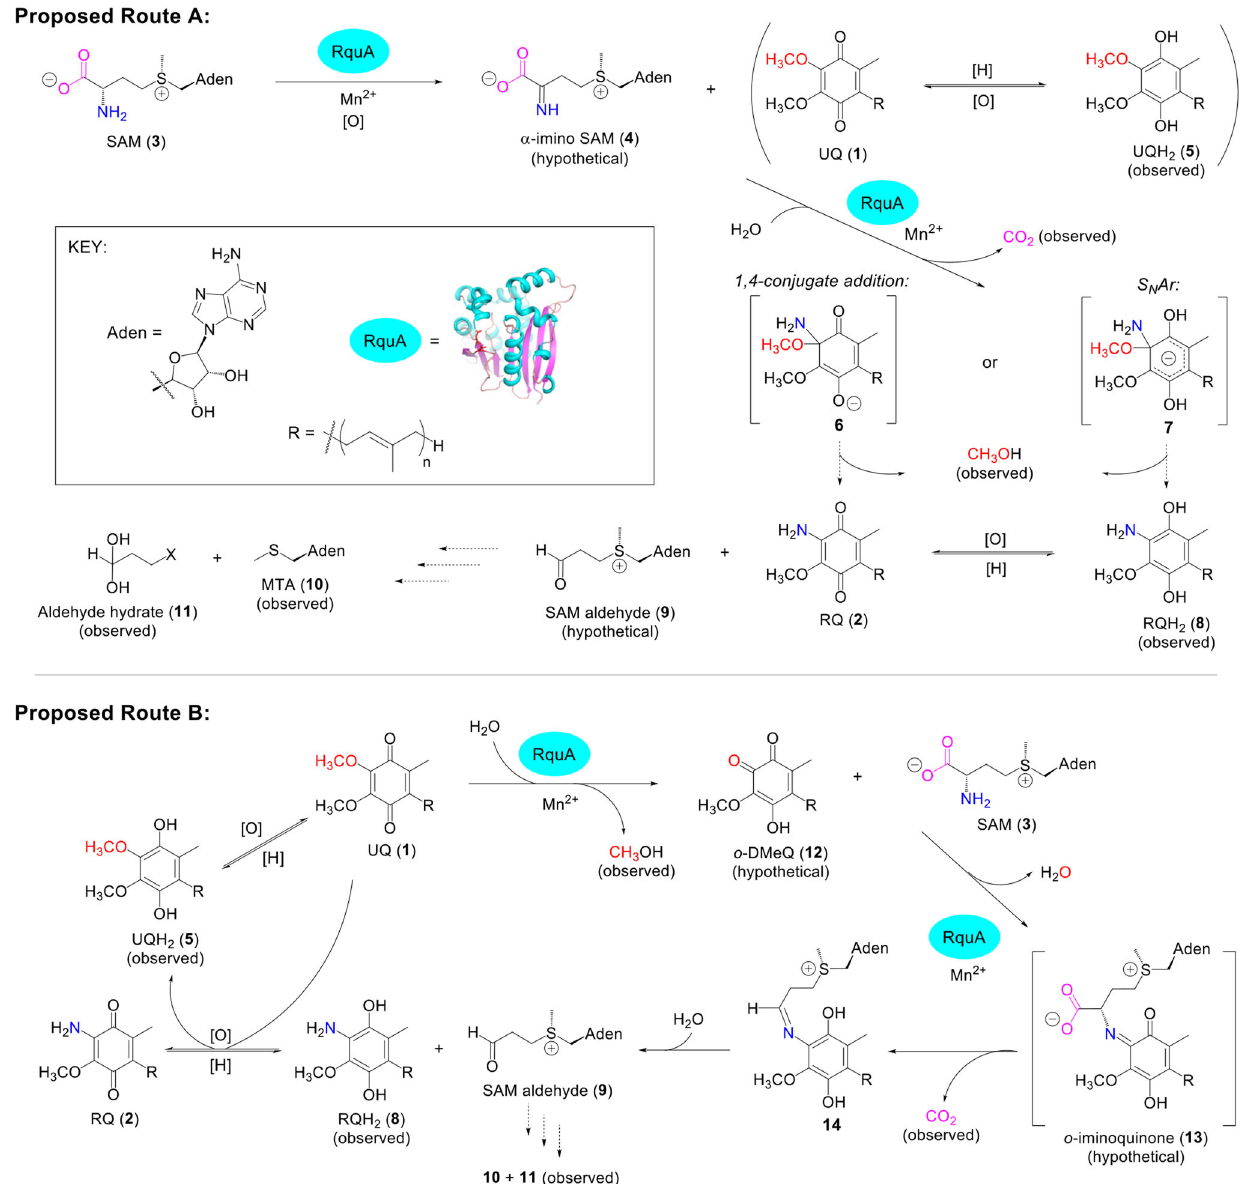
Fig. 6 Proposed routes for the RquA reaction. Ubiquinone (UQ, 1 ) and S -adenosyl- L -methionine (SAM, 3 ) are required substrates of RquA for the biosynthesis of rhodoquinone (RQ, 2 ). The α -amino group (blue) from SAM is transferred to form RQ and decarboxylation (magenta) is observed. The reaction requires the presence of Mn 2 + and both ubiquinol (UQH 2 , 5 ) and rhodoquinol (RQH 2 , 8 ) intermediates are detected during the in vitro assay, as well as CH 3 OH (red), methylthioadenosine (MTA, 10 ), and an aldehyde hydrate ( 11 ). Proposed Route A involves oxidation to form α – imino SAM ( 4 ), followed by decarboxylation and amino substitution via either a 1,4-conjugation addition (intermediate 6 ) or a nucleophilic aromatic substitution (S N Ar, intermediate 7 ) to produce RQ or RQH 2 , respectively. Proposed Route B fi rst assumes the demethylation of UQ to form ortho -demethylubiquinone ( o - DMeQ, 12 ) before the addition of SAM to form an o -iminoquinone ( 13 ), which generates RQH 2 after decarboxylation and hydrolysis. RQH 2 can be oxidized to RQ in either route. Both routes also propose the formation of a SAM-aldehyde product, which through reaction with a nucleophile (X), can decompose to MTA and the observed aldehyde